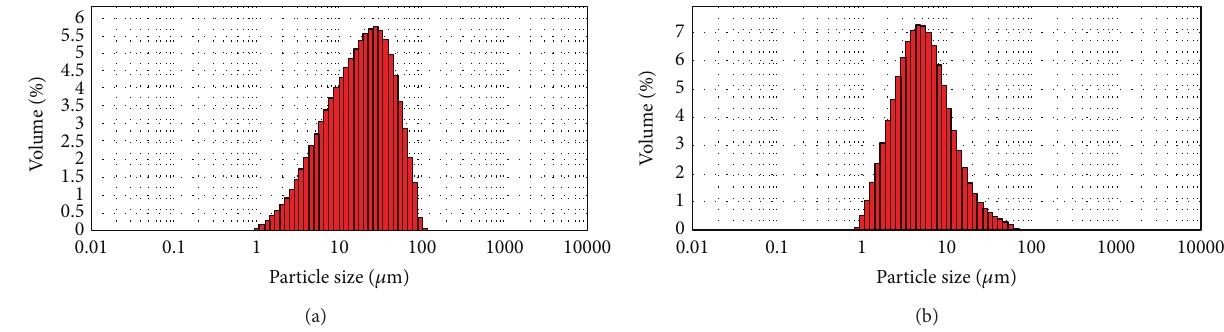
Figure 3: (a) Particle size distribution curve for NFA using laser diffraction analysis. (b) Particle size distribution curve for MFA using laser diffraction